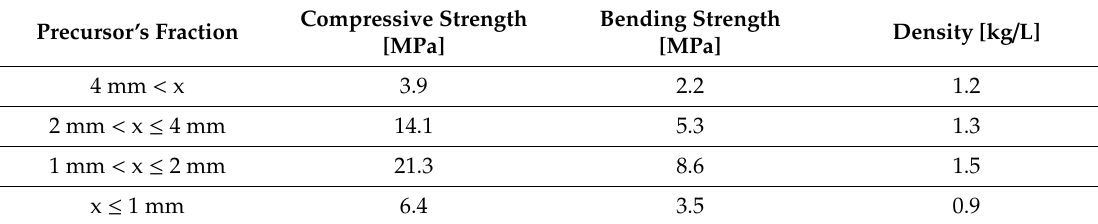
Table 2. The density of alkali activated samples, their compressive and bending strengths in dependence of precursor’s particles’ fraction.